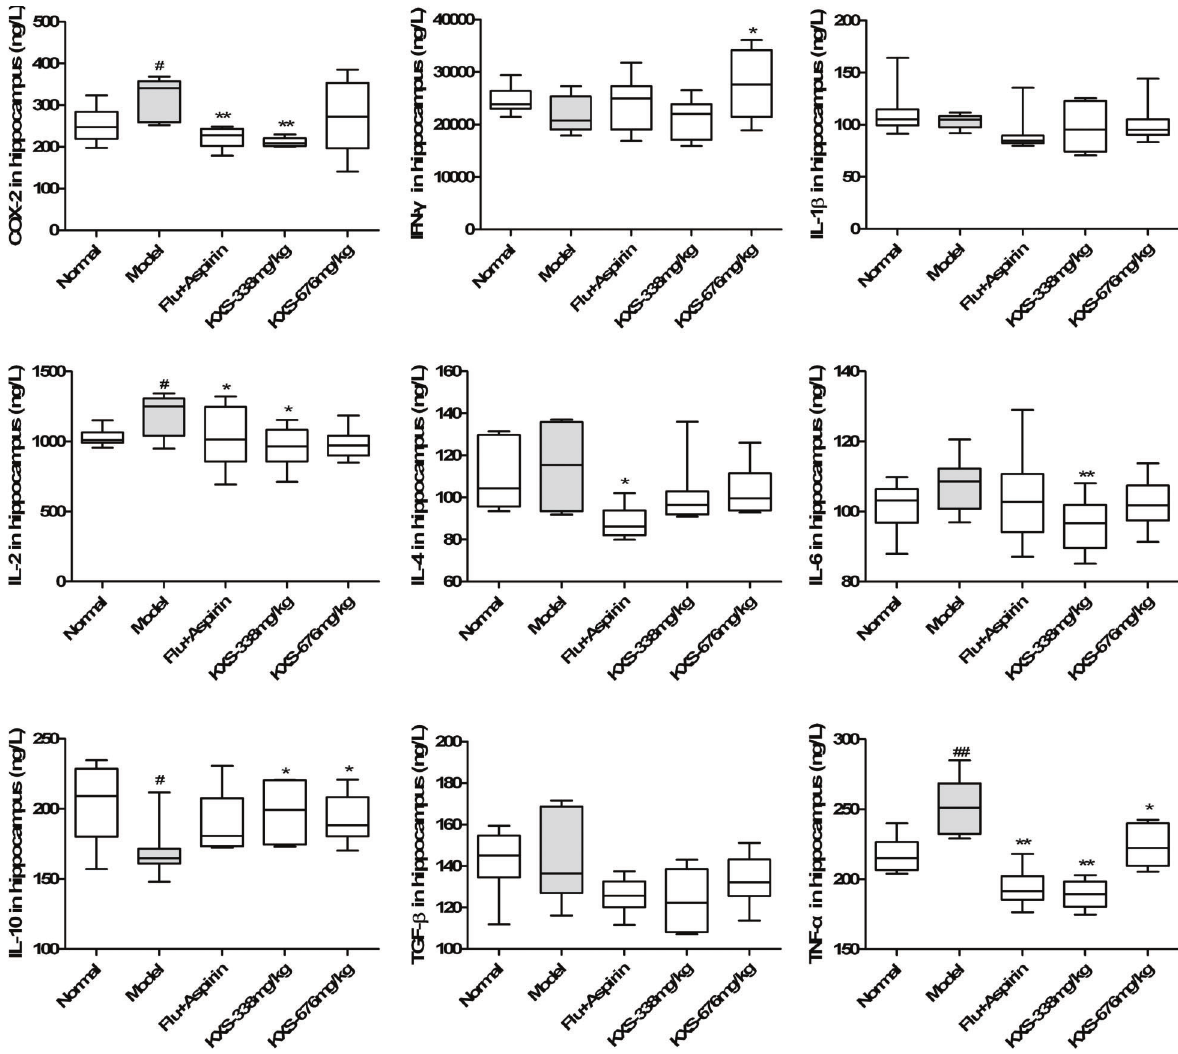
Figure 1. Effects of Kai-Xin-San (KXS) on cytokines in the hippocampus in fl uoxetine-resistant depression (FRD) rats exposed to chronic and unpredictable mild stress model and randomly divided into four groups: FRD model control (Model), oral fl uoxetine and aspirin (Flu + Aspirin), oral KXS at a dose of 338 mg/kg, and 676 mg/kg. Data are reported as means ± SD, n=12. # P o 0.05, ## P o 0.01 compared to untreated Normal group. *P o 0.05, **P o 0.01 compared to Model control group (ANOVA followed by Dunnett ’ s